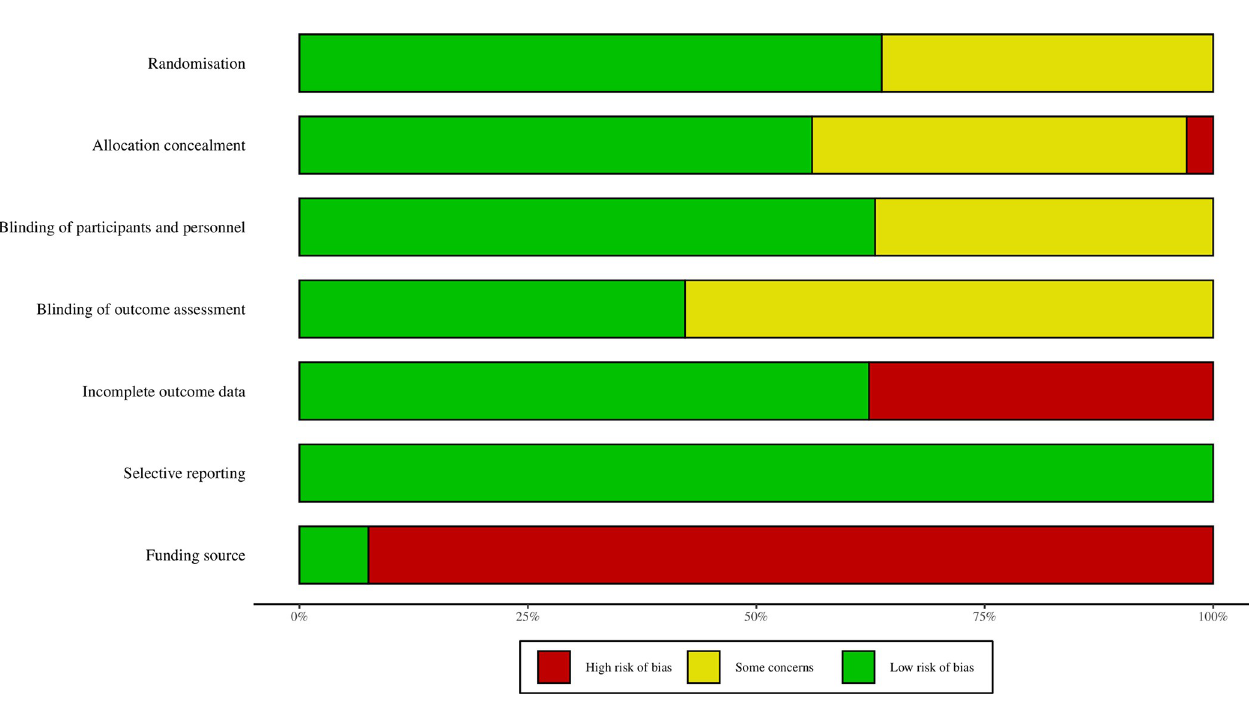
Fig 2. Cochrane risk of bias assessment of 37 trials published in English � . � One trial by Ogawa et al. (2010) excluded [44].